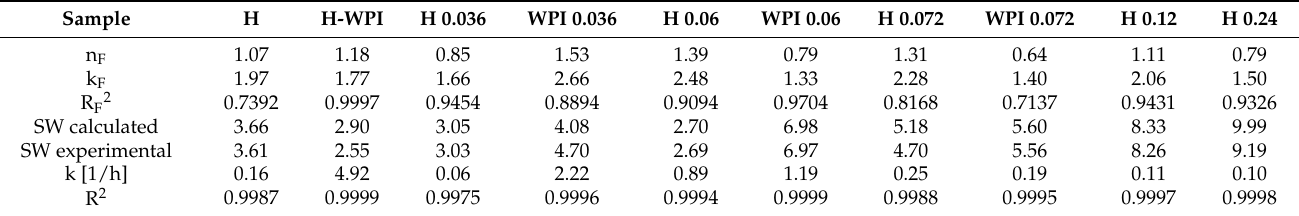
Table 2. There are no clear correlations between the composition of the hydrogels and the values of constants obtained from the Fickian model. Table 2. The variation of swelling degree (experimental and calculated) and rate